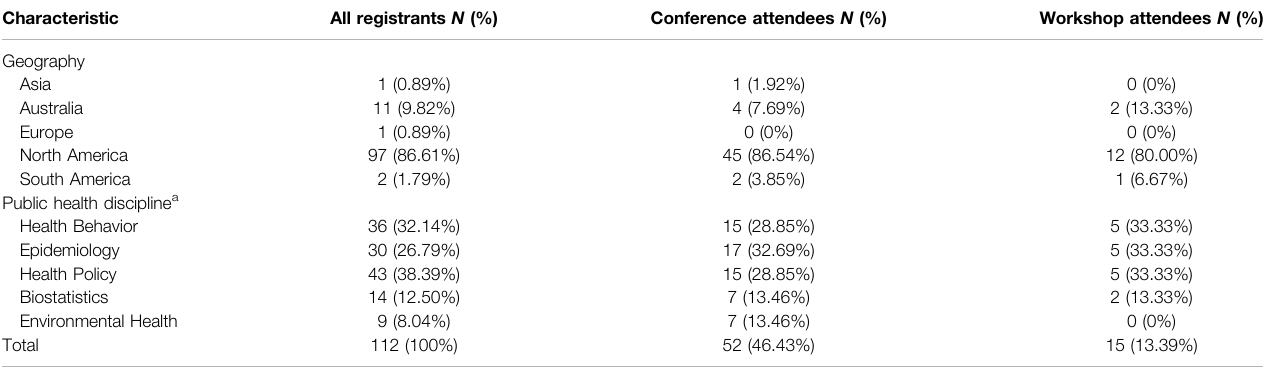
TABLE 1 | Conference participant